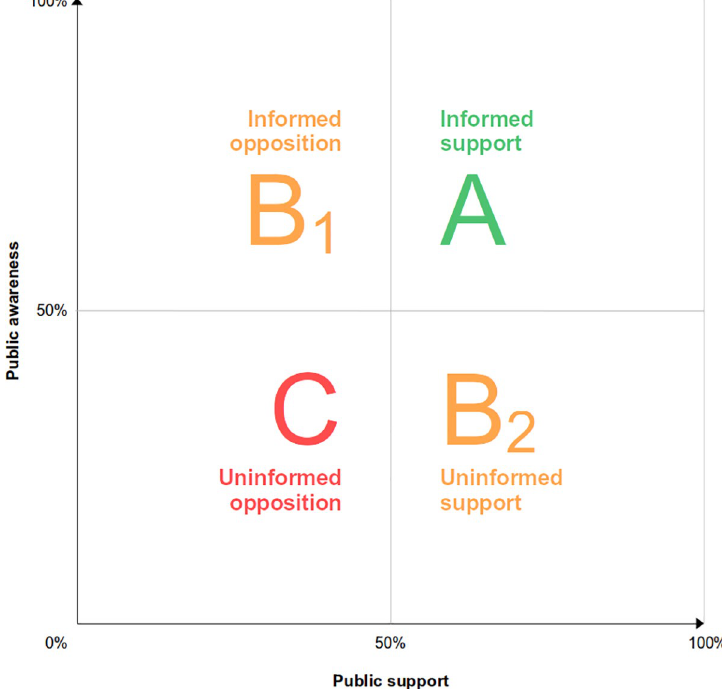
Fig 1. Relation of level of knowledge and supportive attitudes of the public towards consent policies for organ